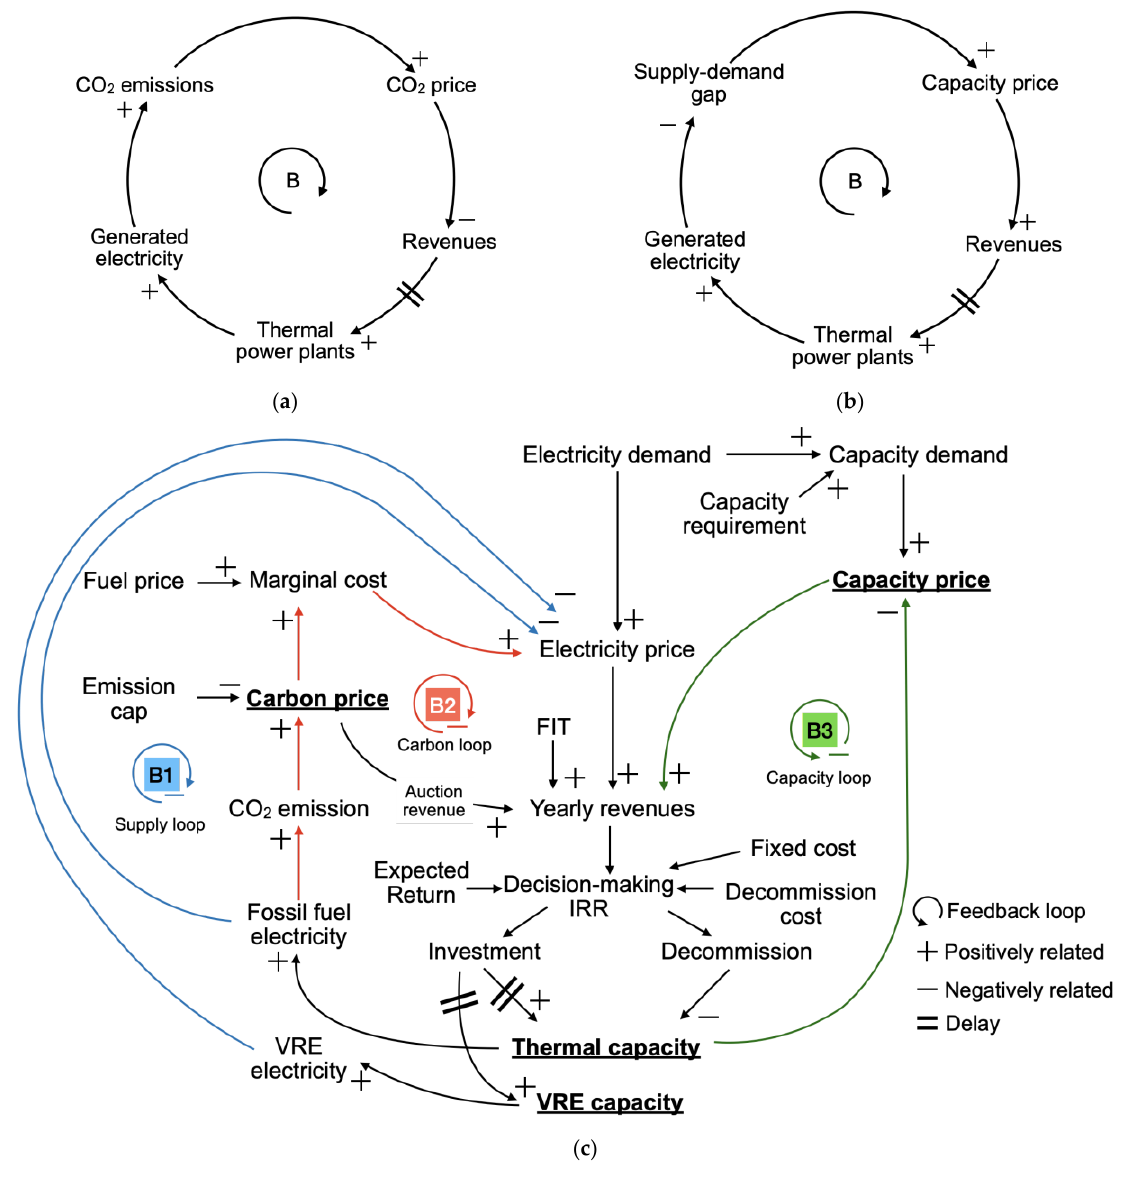
Figure 1. ( a ) Typical causal loop diagram of carbon price functioning ; ( b ) Typical causal loop diagram of capacity price functioning ; ( c ) Causal loop diagram of the proposed framework . Table 1. Comparison of the three technologies